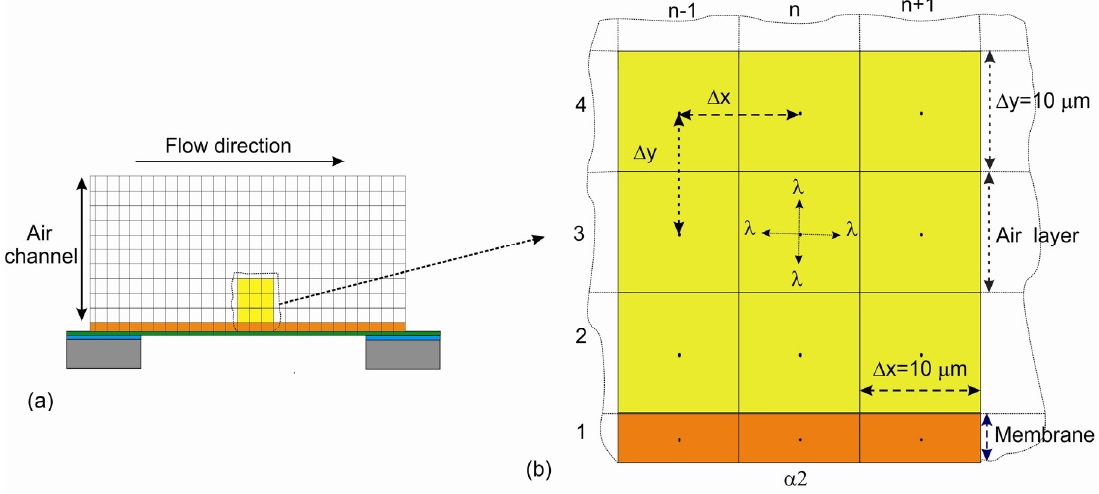
Figure 7. (a) Schematic representation of the two dimensions model which is a cross section in the membrane and the air channel. (b) A sample grid, where λ is the thermal conductivity of air and α 2 is the wall heat transfer